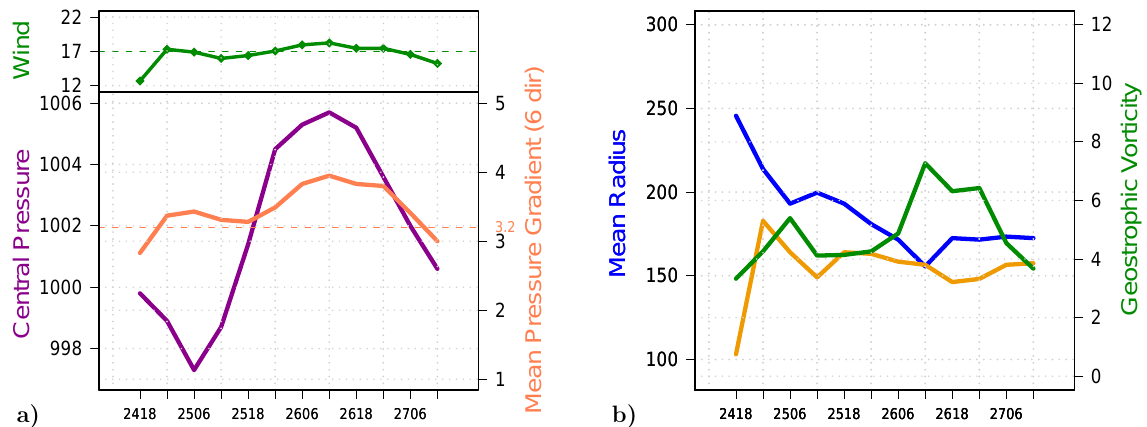
Fig. 2. Evolution over time of (a) gradient wind (ms − 1 ) in green (top) and central pressure (hPa) in violet + mean pressure gradi- ent (10 − 2 hPakm − 1 ) in orange (bottom) (b) mean radius (km) in blue + mean warm core radius (km) in orange + geostrophic vorticity (10 − 4 s − 1 ); for 1982 event.